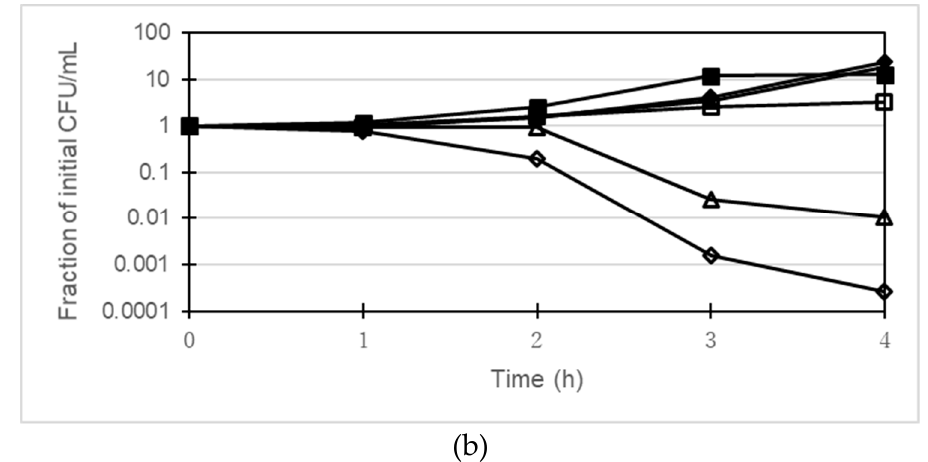
Figure 2. ( a ) Time-kill curves by the combination of gentamicin with berberine or 13-o-MBB against PAGU g 1933, closed squares, control; closed triangles, berberine 256 µg/mL; closed diamonds, 13-o-MBB 64 µg/mL; open squares, gentamicin 2 µg/mL; open triangles, gentamicin 2 µg/mL with berberine 256 µg/mL; open diamonds, gentamicin 2 µg/mL with 13-o-MBB 64 µg/mL; ( b ) Time-kill curves by the combination of gentamicin with berberine or 13-o-MBB against PAGU g 1929, closed squares, control; closed triangles, berberine 256 µg/mL; closed diamonds, 13-o-MBB 64 µg/mL; open squares, gentamicin 2 µg/mL; open triangles, gentamicin 2 µg/mL with berberine 256 µg/mL; open diamonds, gentamicin 2 µg/mL with 13-o-MBB 64 µg/mL.